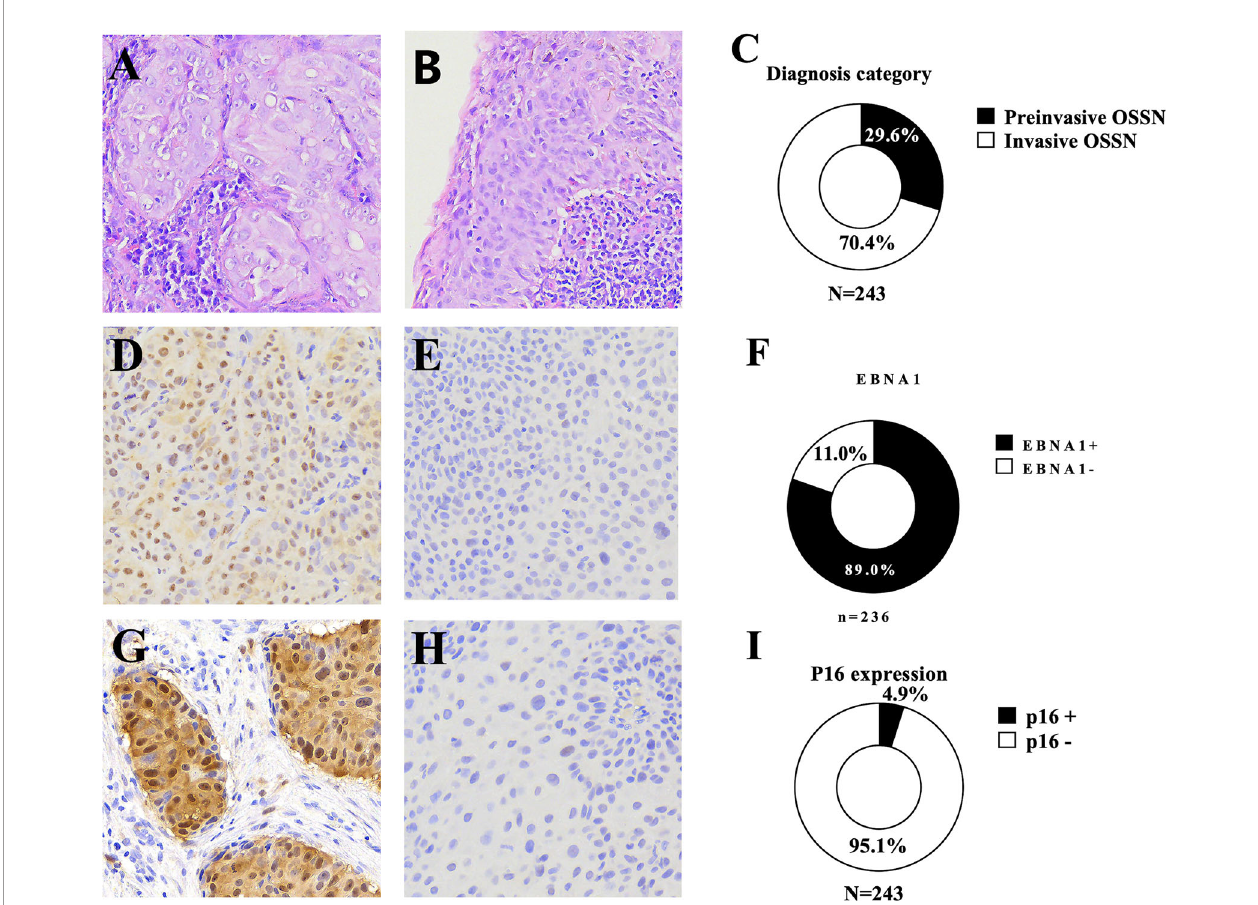
FIGURE 2 | Representative microscopy recorded at ×20 magni fi cation showing (A) non-keratinizing squamous cell carcinoma, (B) a preinvasive ocular surface squamous neoplasia [carcinoma in situ (CIS)] with in fl ammation in the underlying stroma and the overlying epithelium, (C) the frequency of preinvasive and invasive ocular surface squamous neoplasia, (D) an Epstein – Barr virus nuclear antigen 1 (EBNA1)-positive ocular surface squamous neoplasia [immunohistochemistry (IHC)], (E) EBNA1-negative ocular surface squamous neoplasia (IHC), (F) frequency of EBNA1 expression, (G) a p16-positive ocular surface squamous neoplasia, (H) a p16- negative ocular surface squamous neoplasia, (I) the frequency of P16 overexpression in ocular surface squamous neoplasia.